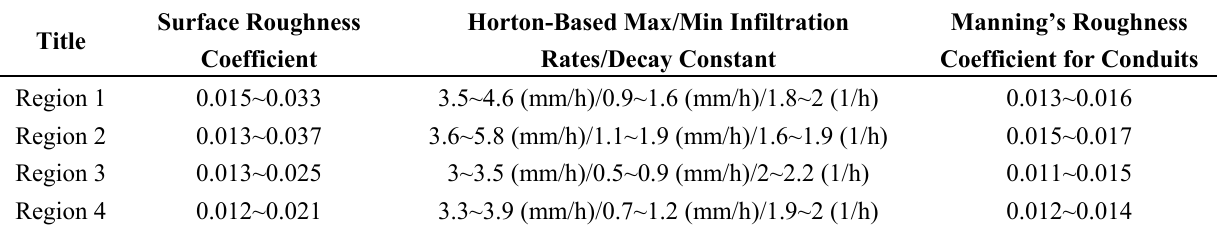
Figure 7. Validation results of SWMM (Jyu-Guang Road). Table 2. Values of the calibrated parameters in